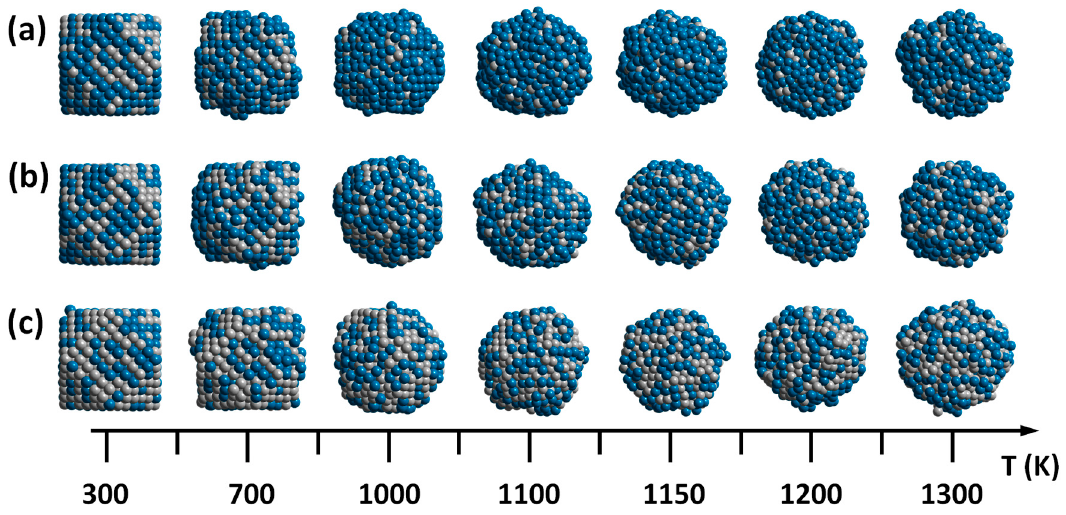
Figure 5. Final configurations after 1000 ps MD run of the nanoparticles at various temperatures for: ( a ) PdPt (2:1), ( b ) PdPt (1:1), and ( c ) PdPt (1:2) nanoparticles, respectively (Pd = blue and Pt = grey).